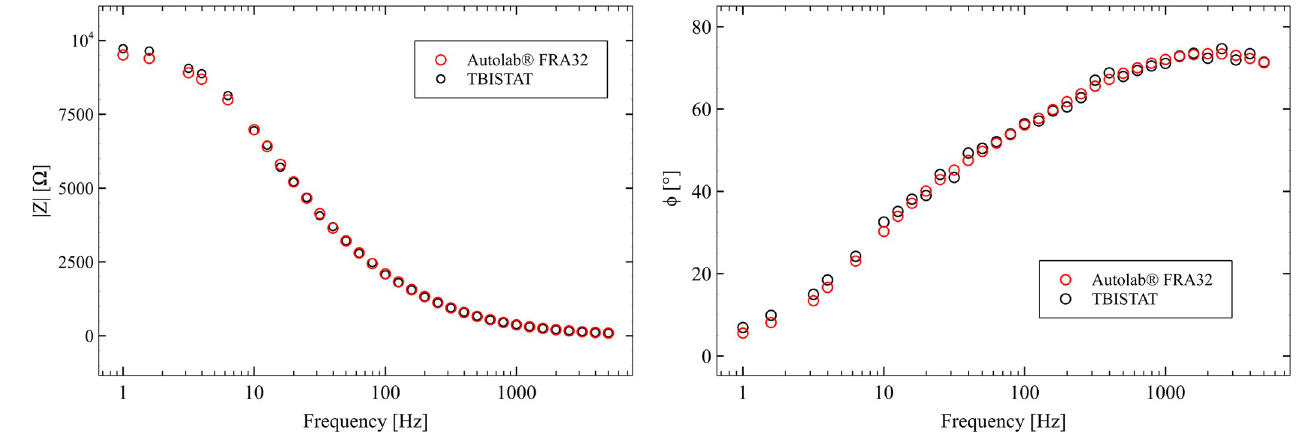
Fig 7. EIS magnitude and phase plots for TBISTAT and reference instrument for measurements in 10mM K3[Fe(CN)6] in 0.2M KCl solution.